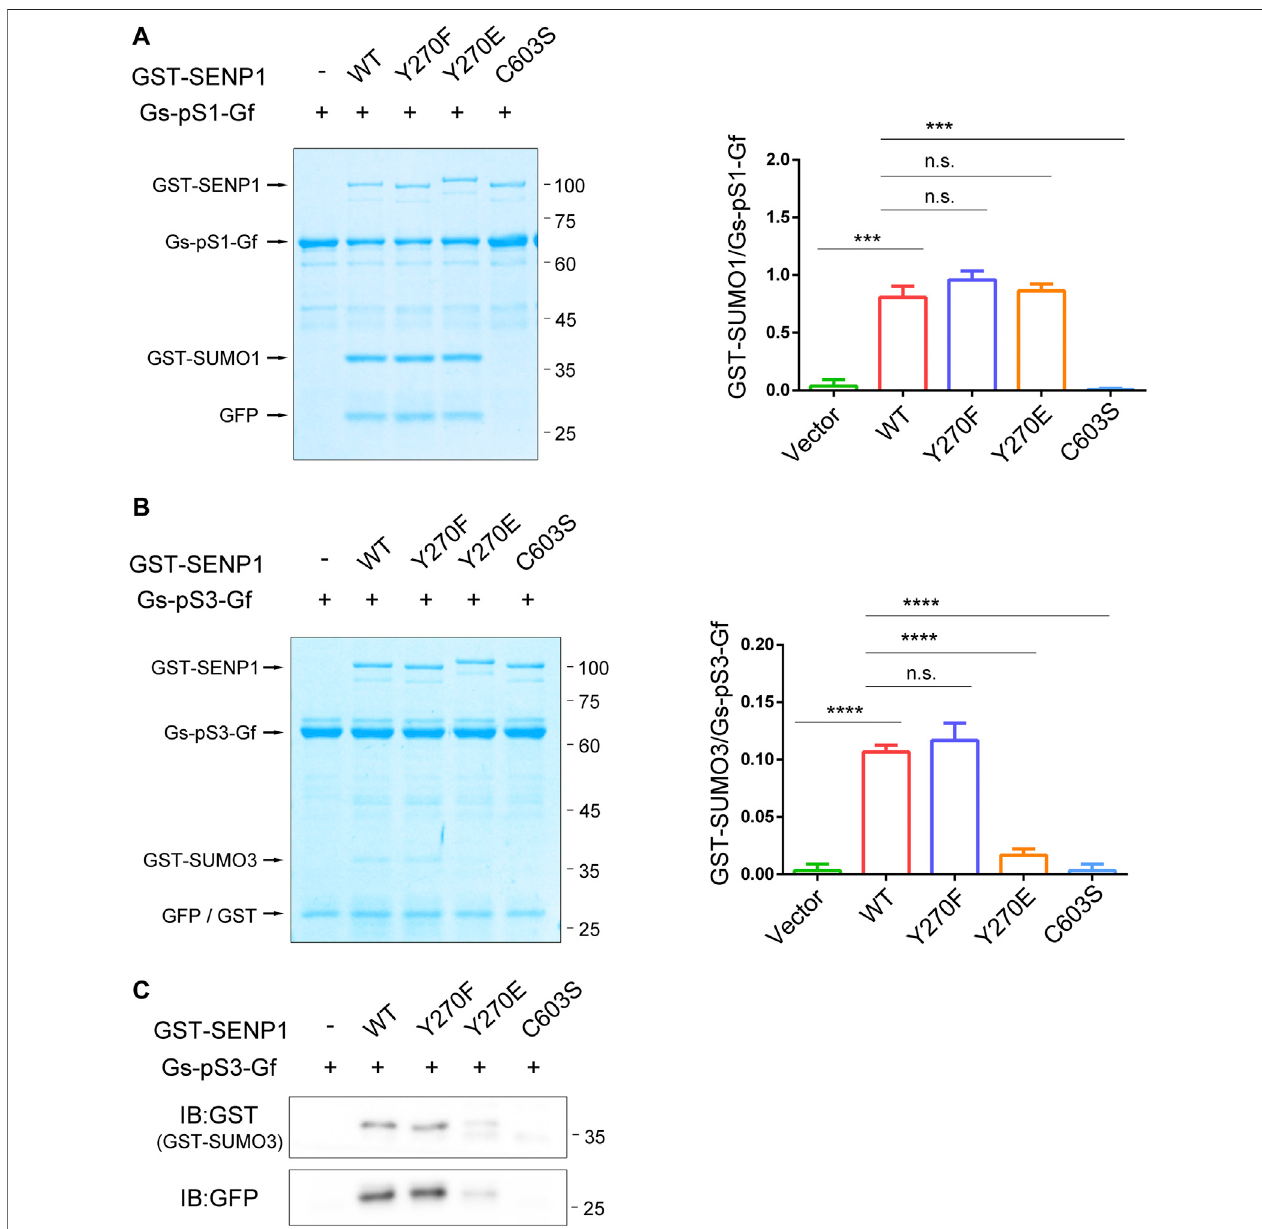
FIGURE 4 | SENP1 Y270E speci fi cally decreases its endopeptidase activity towards pre-SUMO3 in vitro . (A,B) In vitro SENP1 endopeptidase activity assay with puri fi ed glutathione S-transferase (GST)-preSUMO1-GFP (Gs-pS1-Gf, (A) or GST-preSUMO3-GFP proteins (Gs-pS3-Gf, (B) as substrates. GST-SENP1 WT and its Y270F, Y270E, and C603S mutants were incubated with Gs-pS1-Gf or Gs-pS3-Gf at 37 ° C for 20 min, respectively, followed by SDS-PAGE and Coomassie staining to analyzethereactionproductsprocessedbydifferentformsofSENP1.Thedensitometricquanti fi cationoftheratiosofGST-SUMO/Gs-pS-Gf(product/substrate)is shown on the right. n.s., not signi fi cant, * p < 0.05, ** p < 0.01, *** p < 0.001, **** p < 0.0001 (two-tailed unpaired Student ’ s t -test). (C) Samples in (B) were also immunoblotted with anti-GST (GST-SUMO3, top) and anti-GFP (bottom) antibody.